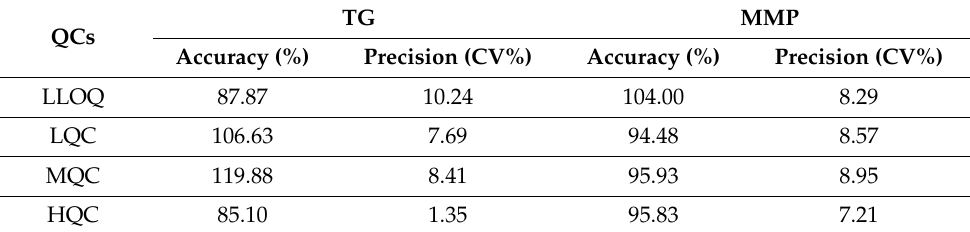
Table 11. Evaluation of stability of TG and MMP after 50 days, represented as accuracy and precision values, in the biological matrix.